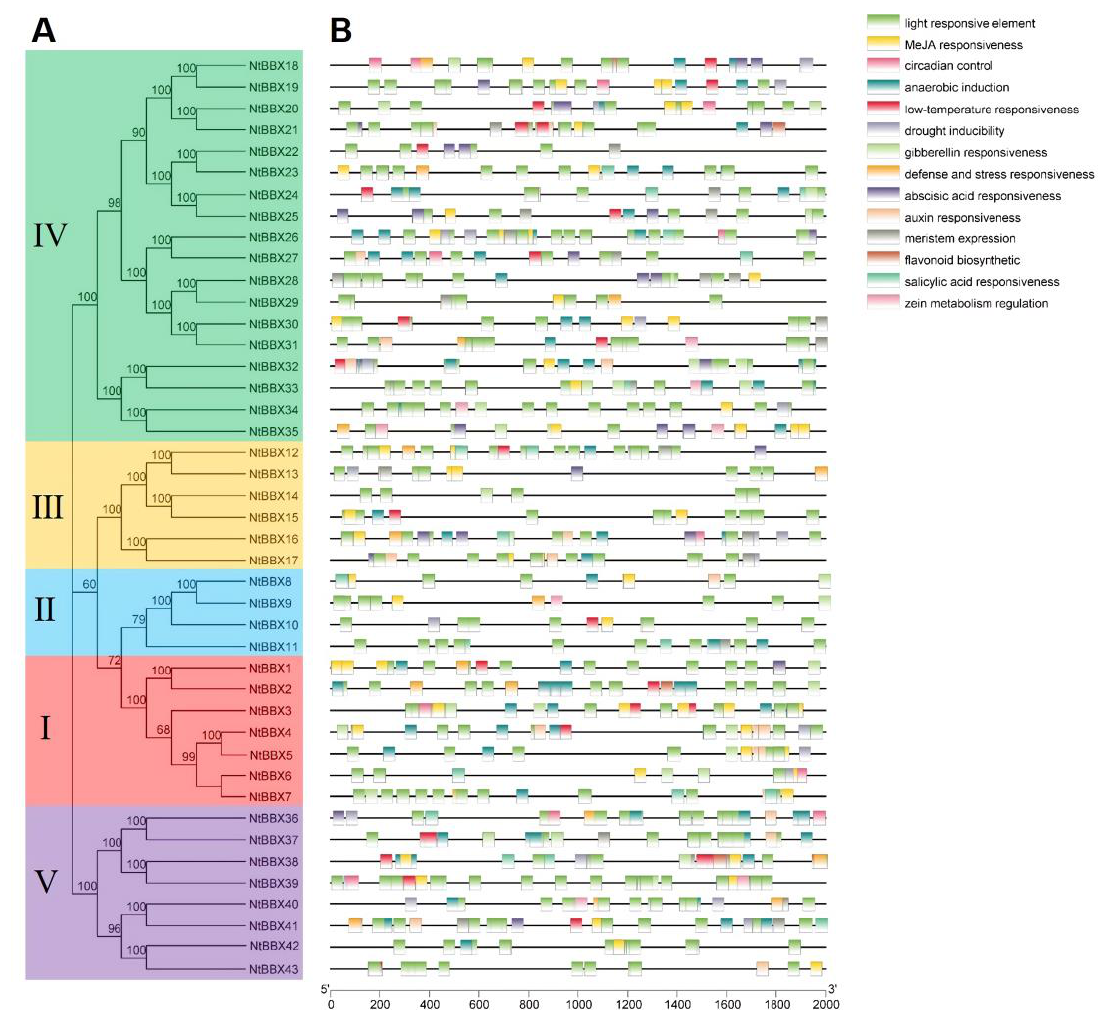
Figure 5. Cis-acting elements in promoter region of NtBBX genes. ( A ) Phylogenetic tree of NtBBX proteins sequences from tobacco; ( B ) Cis-acting elements. Detailed information of cis-acting elements is provided in Supplementary Table S2.